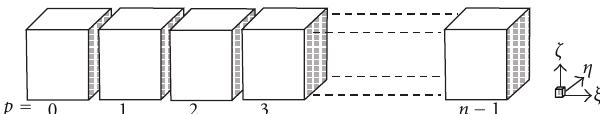
Figure 1: Computation domain.